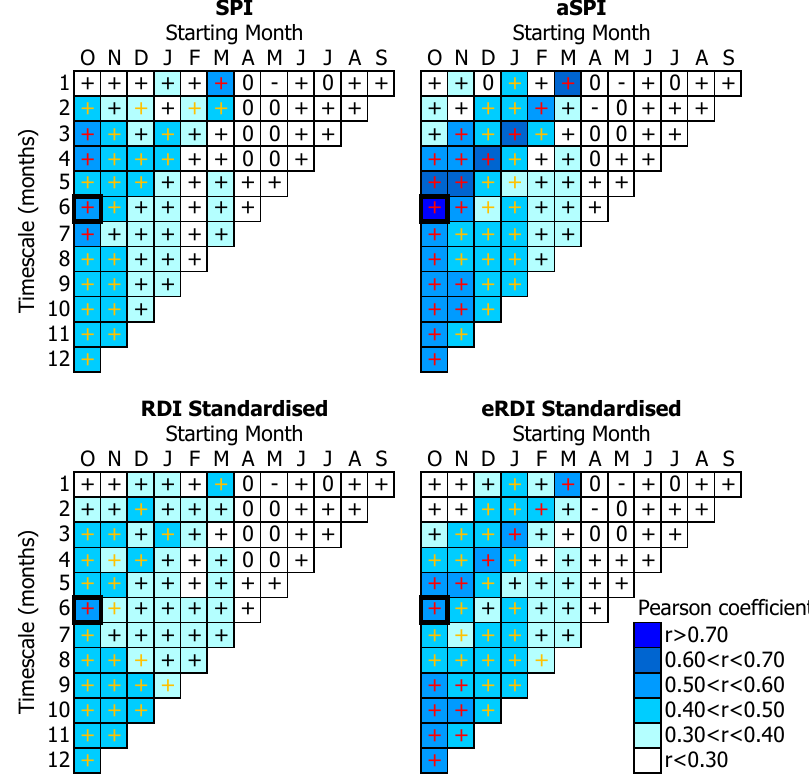
Figure 6. Pearson coefficients ( r ) derived from the correlation of annual TRWI with SPI, aSPI, RDI and eRDI drought indices. The positive correlations are indicated with “+”, the negative with “-” and the negligible ( − 0.1 < r < 0.1) with “0”. The significance level is indicated with red ( p < 0.01), orange ( p < 0.05) or black (not significant) signs, while the strongest correlation (highest absolute r value) per parameter is marked with broader line.